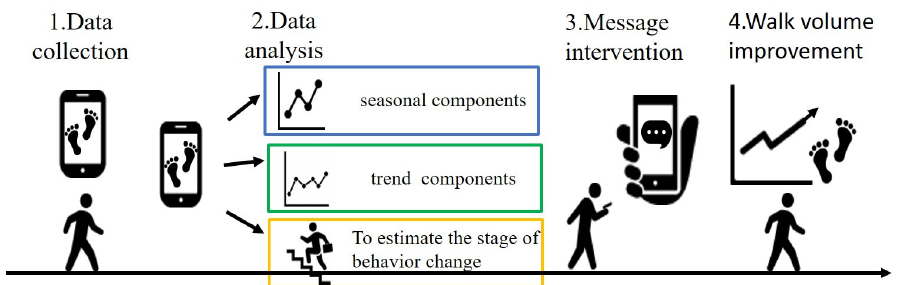
Figure 1. A schematic diagram of the proposed